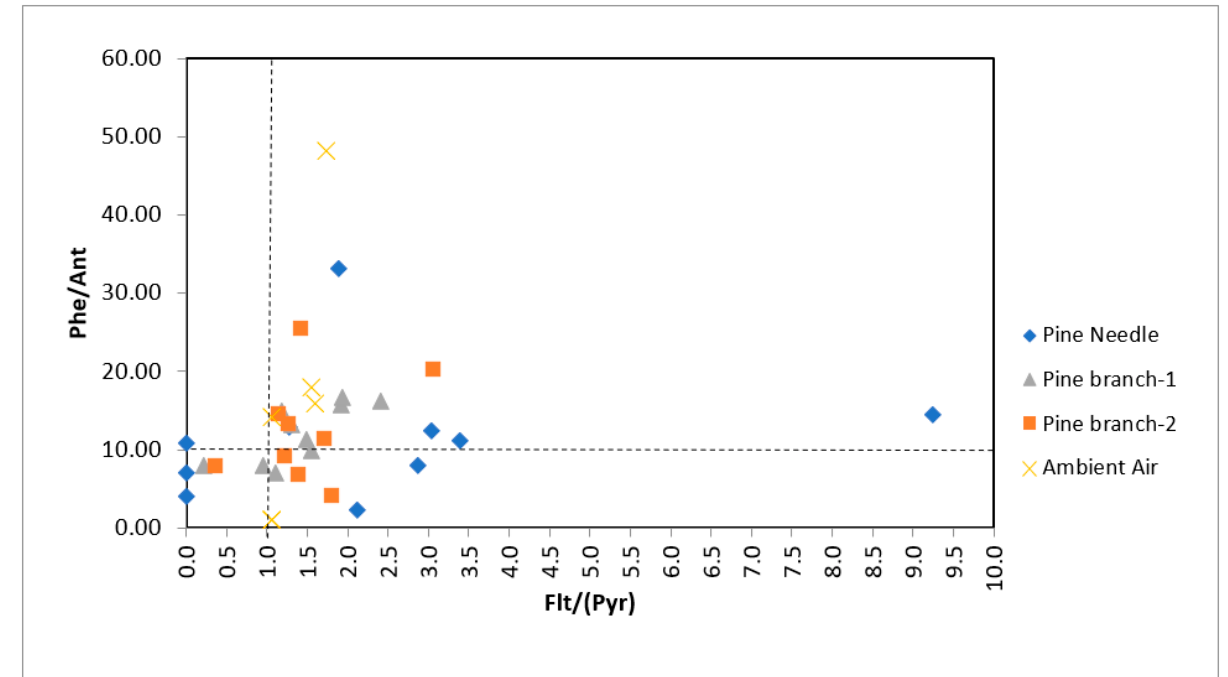
Figure 4. Phe/Ant ratios against Flt/Pyr ratios for the tree components and ambient air. Note: Pine branch-1 and Pine branch-2 refer to 1-year-old and 2-year-old branches. When the Flt/(Flt+Py) and BaA/(BaA+Chr) ratios are examined (Figure 5), it is Indeno/(Indeno+BghiP) ratios (Table 6) in pine needles ranged from 0 to 1.00. This ratio was between 0.31–1.00 and 0–0.56 in 1- and 2-year-old pine branches, respectively. BaA/(BaA+Chr) ratios vary between 0–1.00, 0–0.93 and 0–0.70 in pine needles, 1- and 2- year-old branches, respectively. BaA/(BaA+Chr) and Indeno/(Indeno+BghiP) results indi- cated that most of the sources can be considered as combustion and mixed while the rest can be considered petroleum-related (Figure 5).